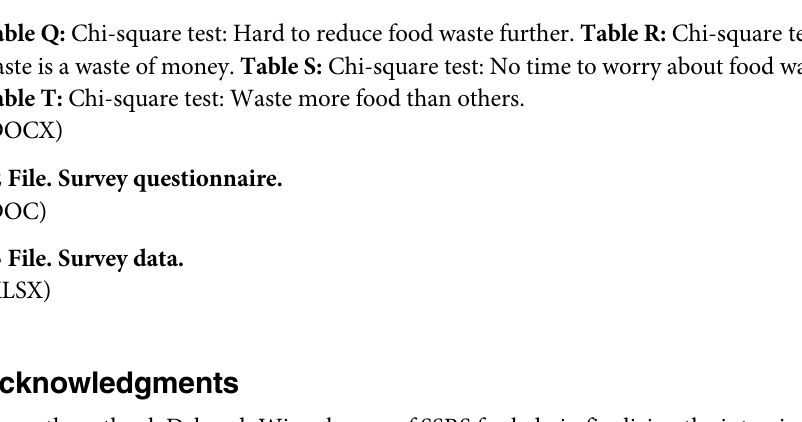
Table Q: Chi-square test: Hard to reduce food waste further. Table R: Chi-square test: Food Table T: Chi-square test: Waste more food than